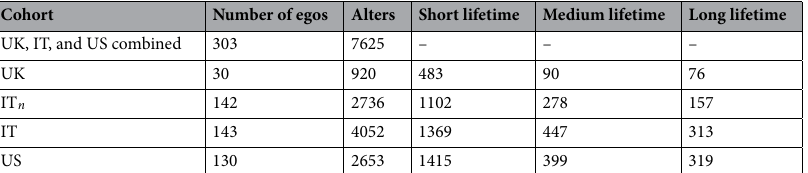
Table 2. Number of transient ego-alter pairs by cohort with (cid:31) t w = 60 days (and (cid:31) t s = 50 days for IT n only). The last three columns show the exact number of relationships specifically used in the lifetime groups of Fig. 1 which represent a subset of all the transient relationships contained in the data.